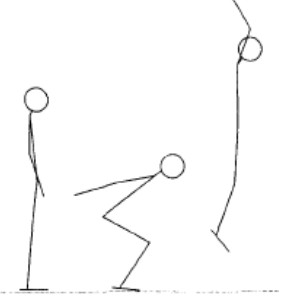
Figure 2. Sequences of Abalakov jump.